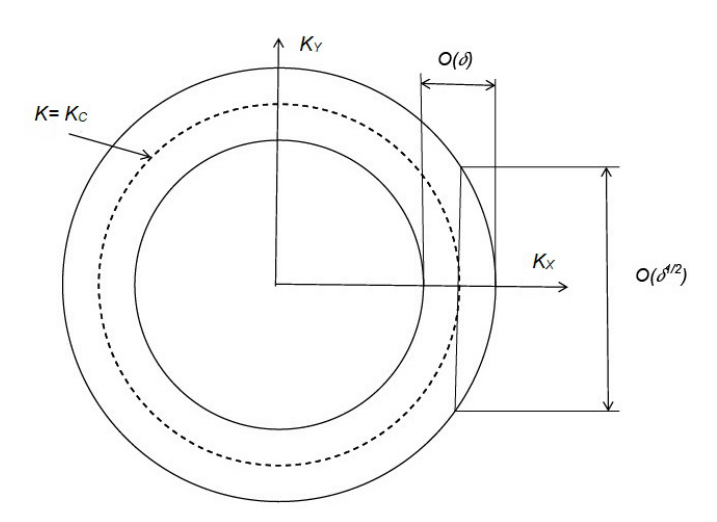
Figure 7. Ring of unstable